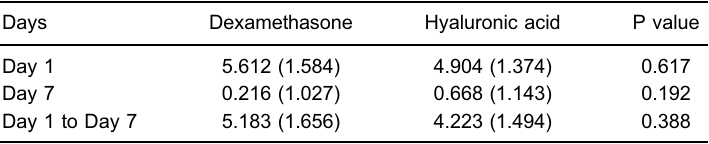
Data are reported as means and standard deviations for n=52 children/group ( t -test). Numeric rating scale (score range: 0 – 10). Table 4. Comparison of characteristics of the two groups of children with recurrent aphthous ulcers treated with dexamethasone or hyaluronic acid after 7 days of treatment. Characteristics Dexamethasone